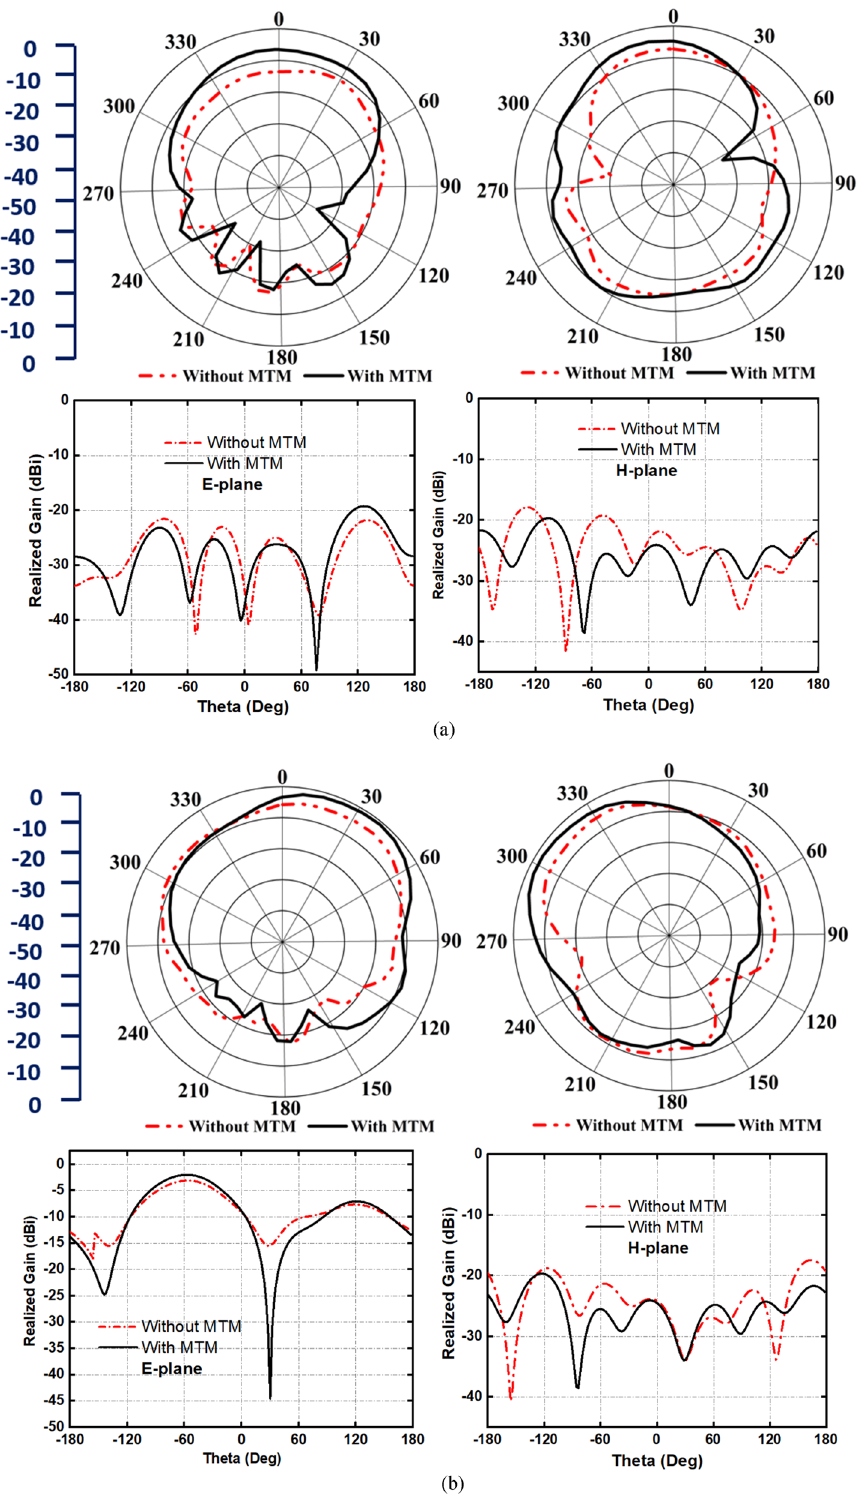
Figure 15. Antenna radiation and cross-polarization behavior with and without metamaterial structure in close proximity to the head phantom. E-plane and H-place at ( a ) 2.2 GHz, ( b ) 3.2 GHz, and ( c ) 3.85 GHz,